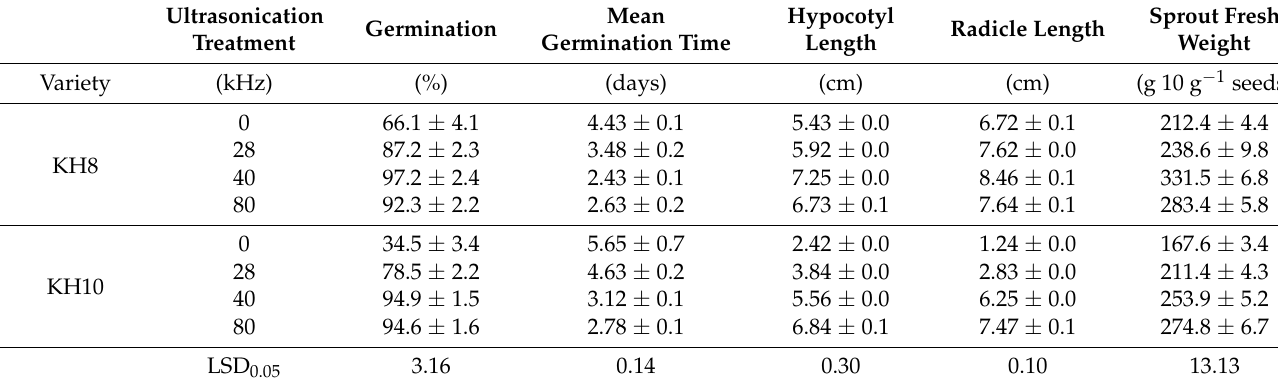
Table 1. Effects of different ultrasonication treatments (28 kHz, 40 kHz and 80 kHz) on the germination percentage, mean germination time, hypocotyl length, radicle length, and sprout yield of 6-days-old sprouts of two adzuki bean varieties. Ultrasonication